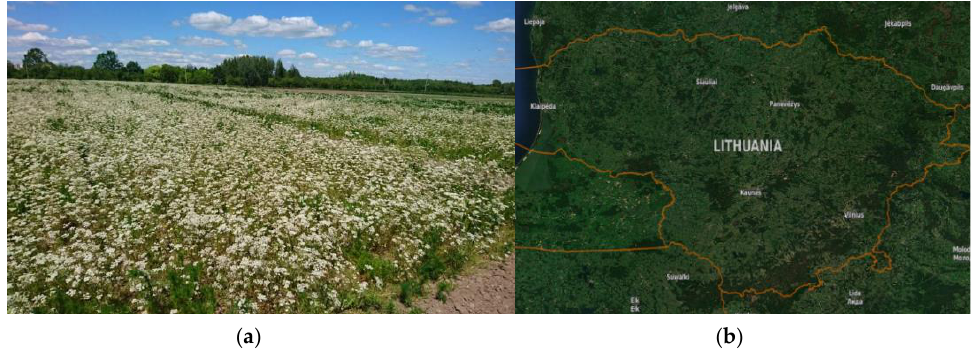
Figure 1. Experimental site: ( a ) caraway flowering in multi-cropping system. ( b ) Sentinel-2 map of Lithuania, available online (https://maps.eox.at/#data) accessed on 4 January 2021. Coordinates: 54°53′8.61″ N, 23°50′16.81″ E longitude.